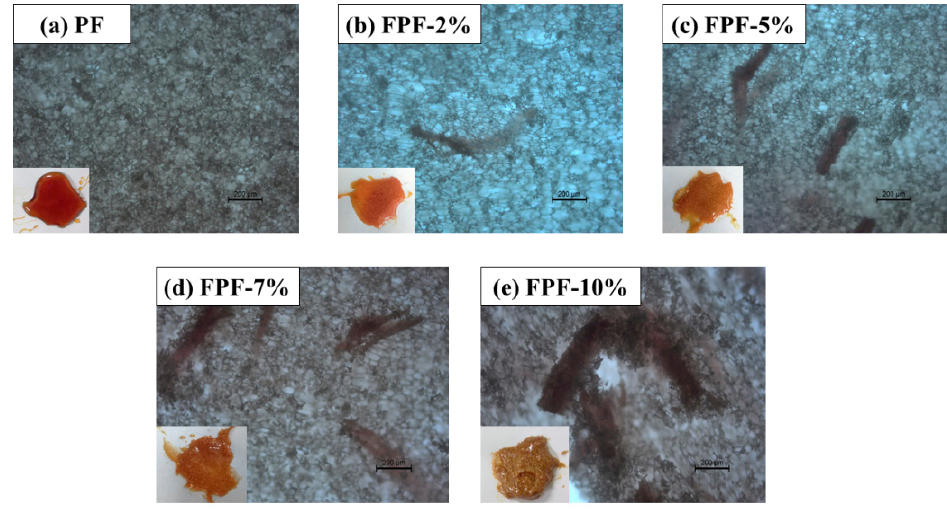
Figure 5. The distribution of fibers in foams.